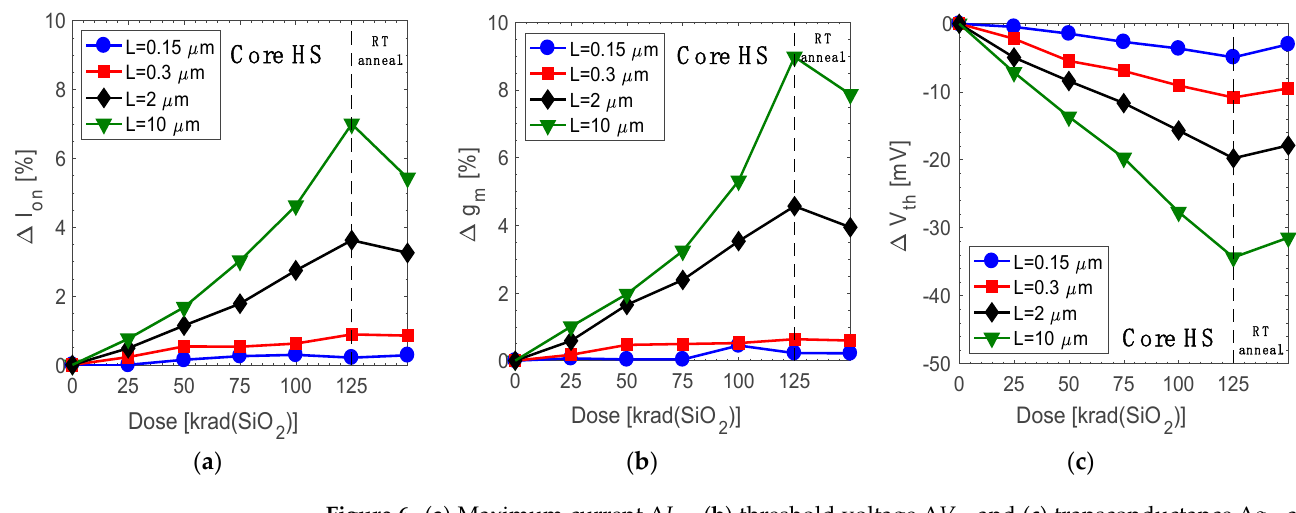
Figure 6. ( a ) Maximum current Δ I on , ( b ) threshold voltage Δ V th and ( c ) transconductance Δ g m as a function of dose for core HS nMOSFETs of different channel lengths. The channel width is the narrowest available ( W = 0.32 mm). Transistors measured at room temperature in linear regime ( V ds = 0.1 V) during the irradiation up to 125 krad(SiO 2 ) and after annealing at room temperature for 24 h.